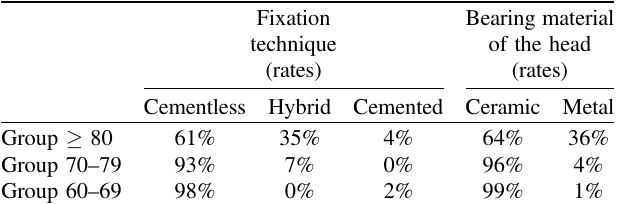
Table 3. Fixation technique and bearing material of the femoral